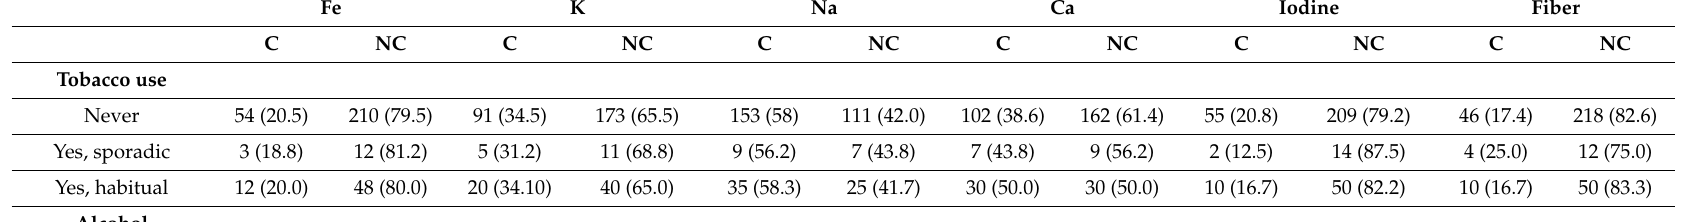
Table 7. Relationship between lifestyles and compliance with daily recommended intakes for minerals and